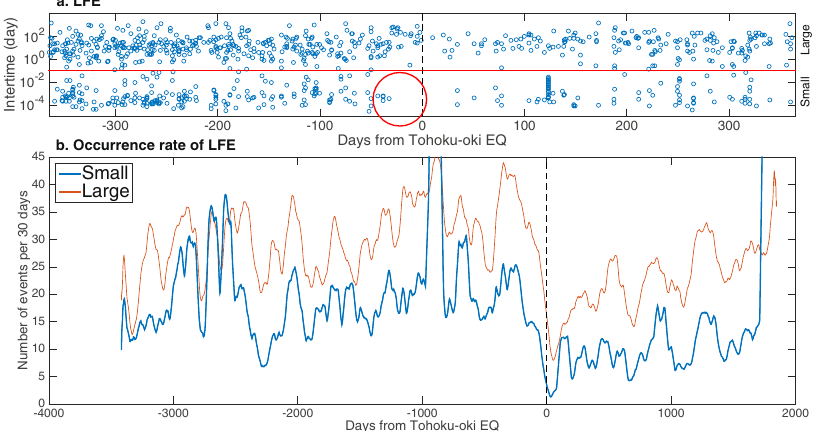
Figure 2. Preliminary analysis of the LFE occurrence patterns. Panel a: Each point denotes the pre-event of a pair of LFEs for a given inter-time. The horizontal axis denotes days from the Tohoku-oki EQ while the vertical axis denotes inter-time. The red line indicates a border between two classes: ‘Large’ class with inter-time greater than 10 − 1 days; ‘Small’ class with inter-time less than 10 − 1 days. Panel b: Evolution of LFEs for these two classes. The number of LFEs denoted by n ( z ) is evaluated with the width of window set 30 days backward: